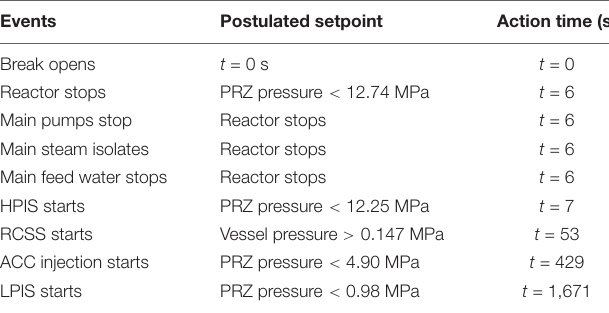
TABLE 2 | Event sequence of SBLOCA transient.